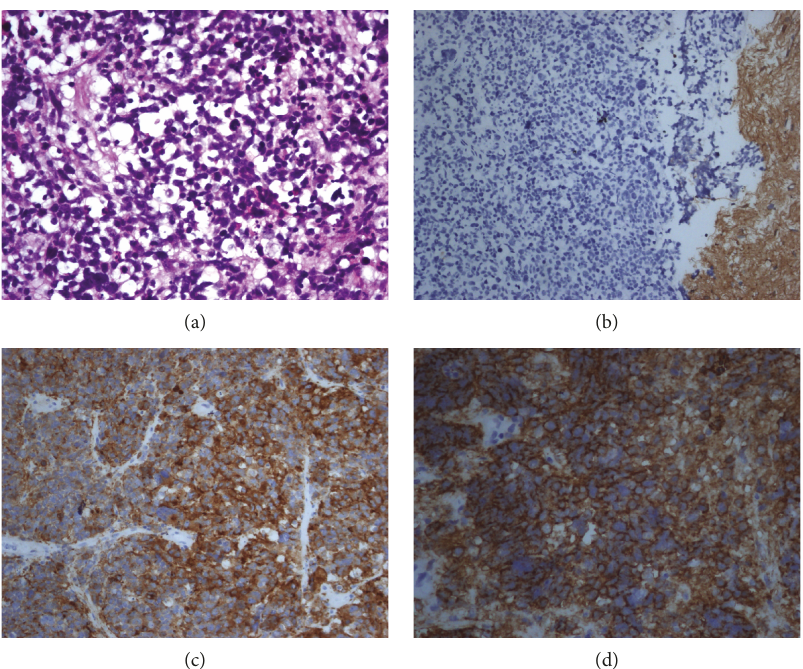
Figure 4: (a) Neoplastic cells with nuclear pleomorphism, hyperchromatism, abundant mitosis, and apoptosis (200x). Immunohistochemistry revealed (b) focal weak positivity for GFAP (200x), (c) synaptophysin(+) (400x), and (d) CD56(+)